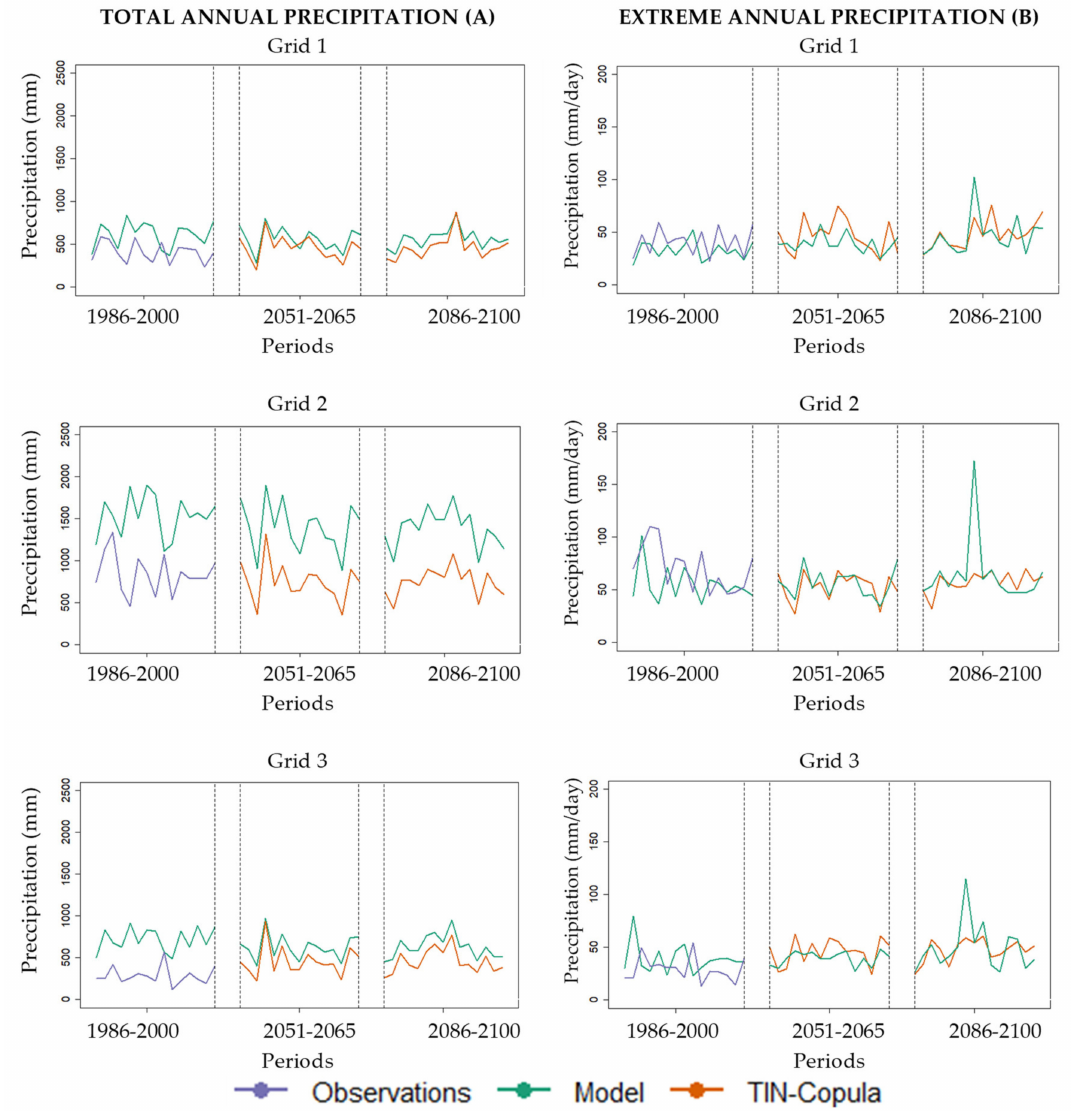
Figure 12. Projection for the annual total ( A —left panels) and extreme ( B —right panels) precipitation, before and after bias correction (model—TIN-Copula), for three selected grid points (Figure 1) and for two future